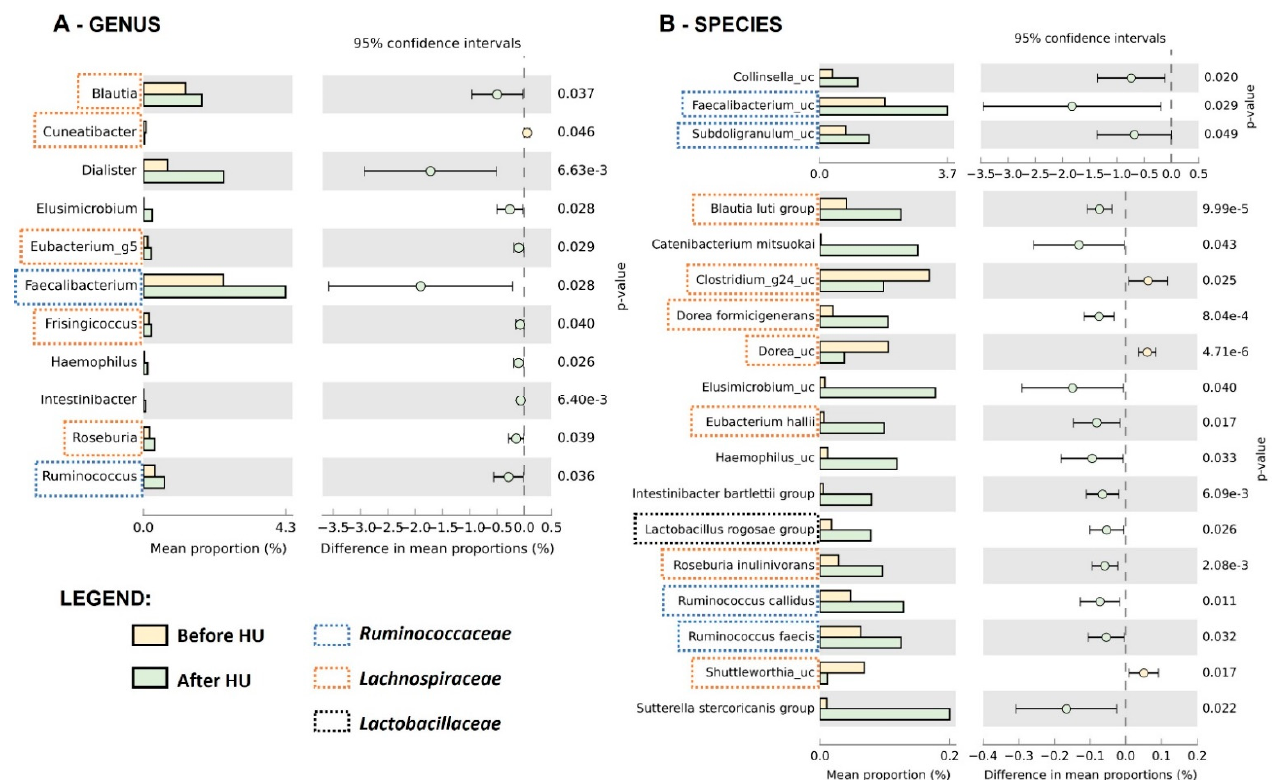
Figure 2. ( A ) Phylum-level and ( B ) Order-level composition of the microbial community after sequencing. Bacteria with a relative abundance of less than 1% were grouped as “Other”.